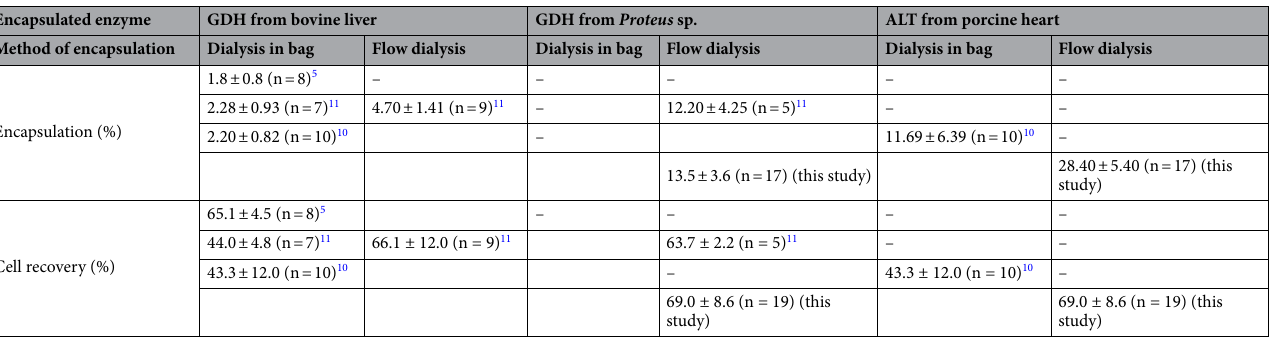
Table 1. Efficiency of encapsulation of ALT and different types of GDH, as well as cell recovery for different methods of enzyme loading. Mean values and standard deviations (mean ± SD) are presented for human